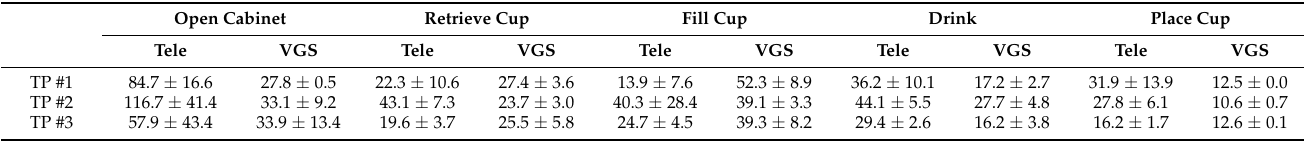
Table 4. Subtask time spent in seconds during teleoperation and VGS control (standard deviation was over five trials).